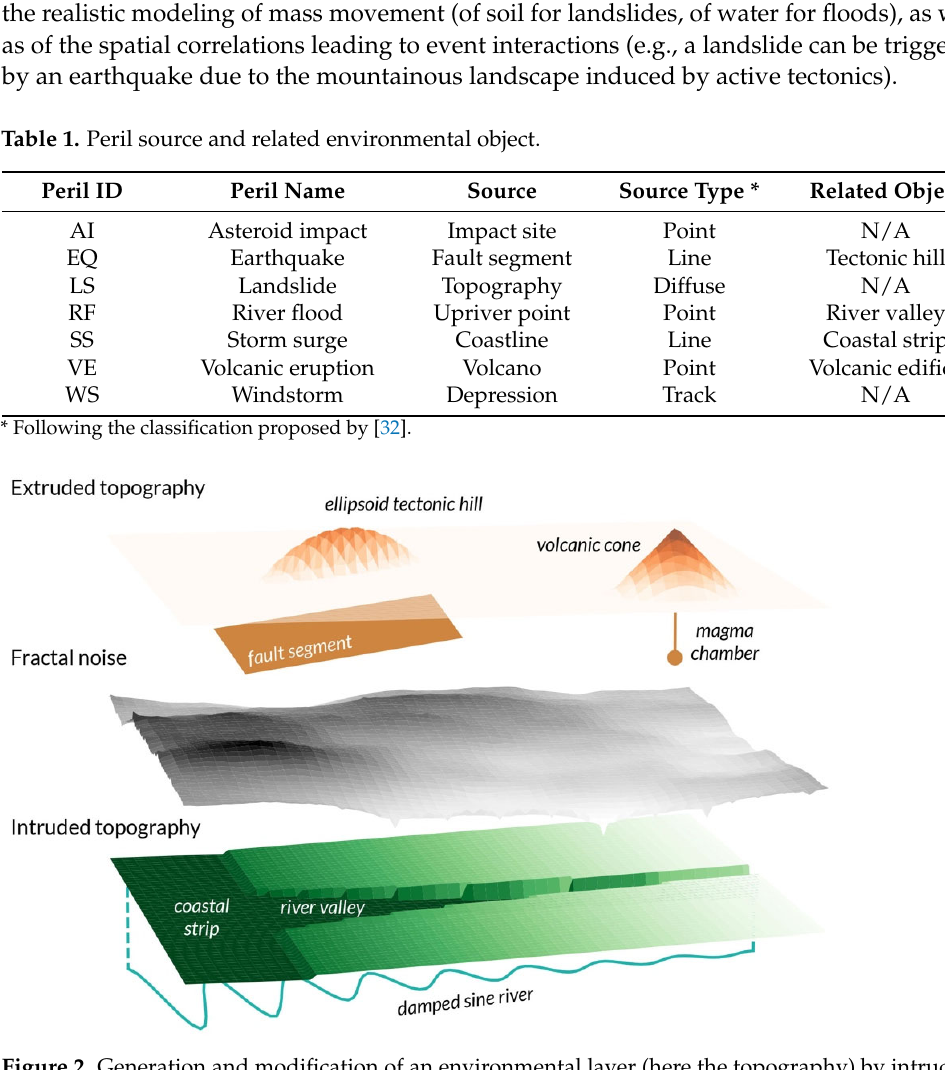
Table 1. Peril source and related environmental object.